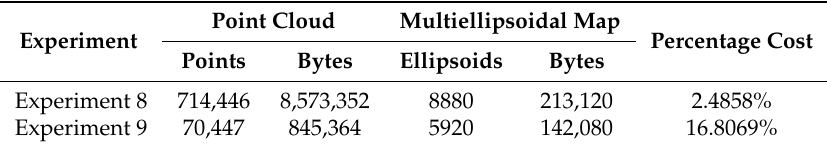
Figure 11. Experiment 9. Table 3. Memory cost of the representation—part